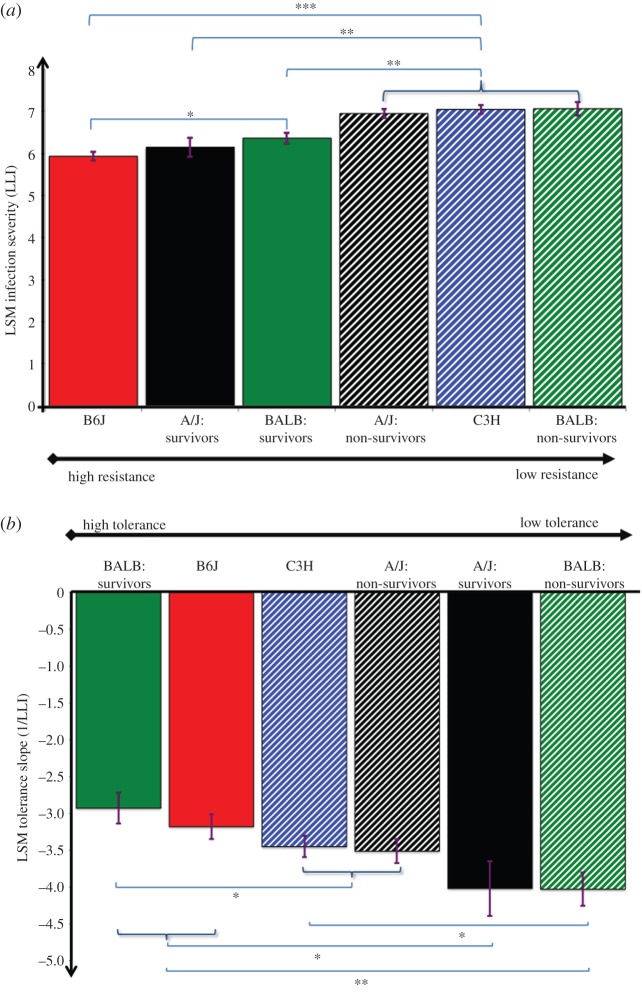
Least square mean (LSM) estimates for resistance and tolerance based on measures of maximum infection severity and minimum health. (a) LSM resistance quantified as the inverse of peak infection severity (LLI). (b) LSM tolerance (defined as regression slope based on regressing maximum %BW loss against LLI). Different mouse inbred strains are indicated by different colours and mouse strains or defined subgroups that succumbed to infection are indicated by dotted lines. LSM estimates (standard errors, s.e.) for LLI ordered from least to most resistant were: BALB non-survivors: 7.06(0.16); C3H: 7.04(0.10); A/J non-survivors: 6.95(0.11); BALB survivors: 6.36(0.13); A/J survivors: 6.14(0.23); B6J: 5.93(0.10). LSM tolerance estimates (s.e.) ordered from least to most tolerant were: BALB non-survivors: −4.03(0.23); A/J survivors: −4.02(0.37); A/J non-survivors: −3.51(0.17); C3H: −3.45(0.15); B6J: −3.18(0.17); BALB survivors: −2.93(0.21). Stars indicate statistically significant differences from pairwise comparison (***p < 0.001; **p < 0.01, *p < 0.05).